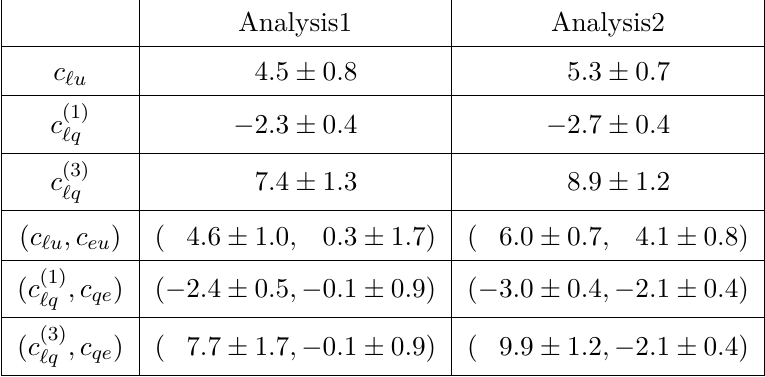
at the EWSB scale, µ = M but induce b → sµ + µ − via EW radiative corrections. The LEFT operators, Q